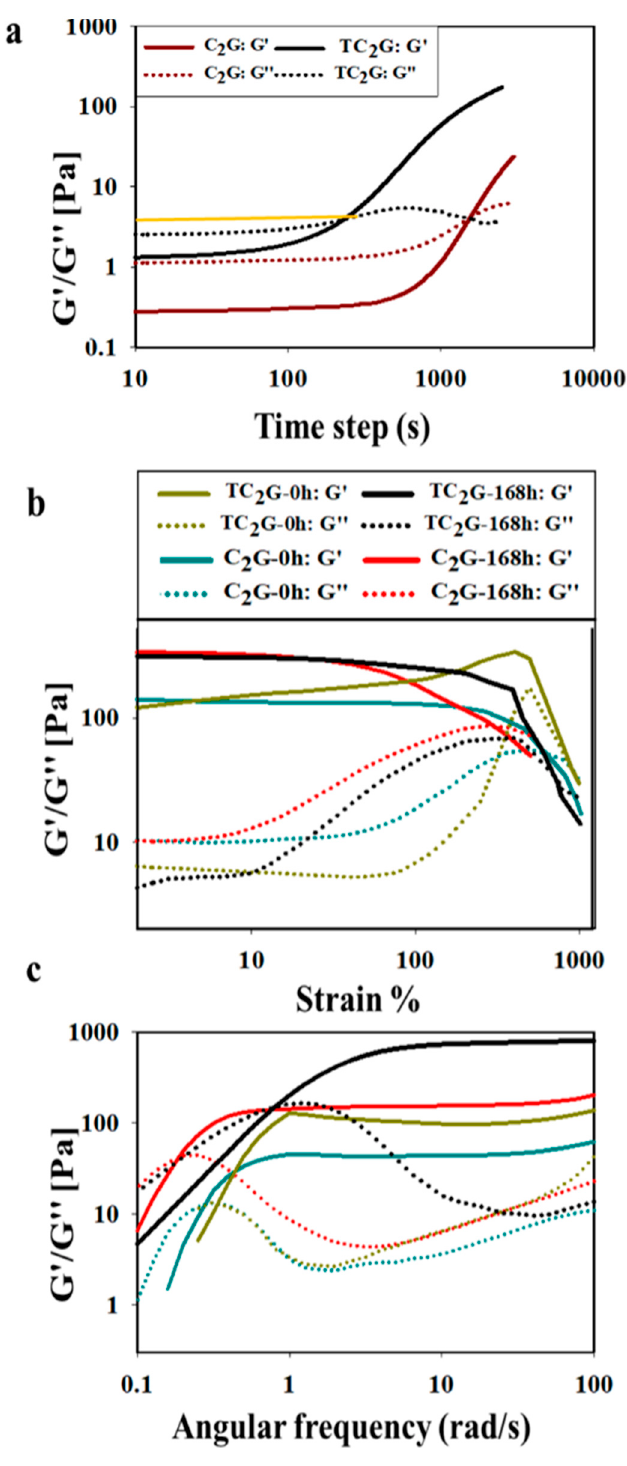
Figure 4. ( a ) Time dependence of the storage (G’) and loss (G’’) moduli for C 2 G and TC 2 G. The gel point of TC2G was around 243s and 1627s for C 2 G and both gels had an identical modulus at the crossover-point. ( b ) Loss modulus (G ′ ), storage modulus (G ′′ ) as a function of strain for TC 2 G and C 2 G immediately after gelling and one week after. ( c ) Loss modulus (G ′ ), storage modulus (G ′′ ) as a function of frequency for TC 2 G and C 2 G immediately after gelling (G ′ /G ′′ /complex viscosity 1) and one week after gelling. TC 2 G has the highest storage moduli over one week.